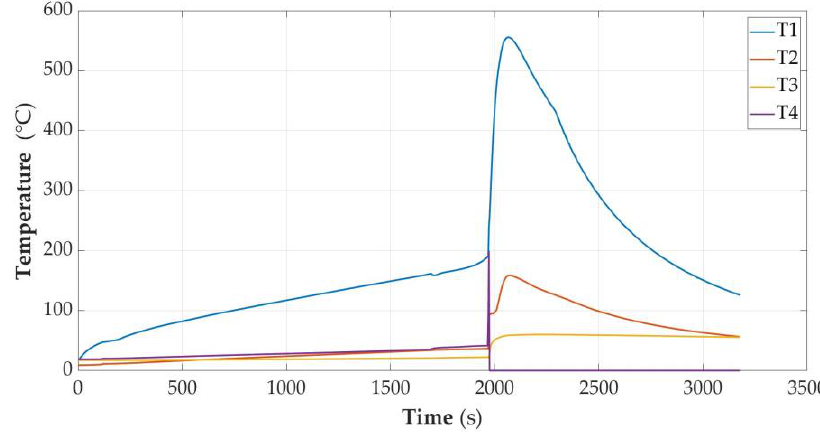
Figure 8. Graphs of temperature changes during heating and energy supplied to the cell module in the SOC = 100% state.